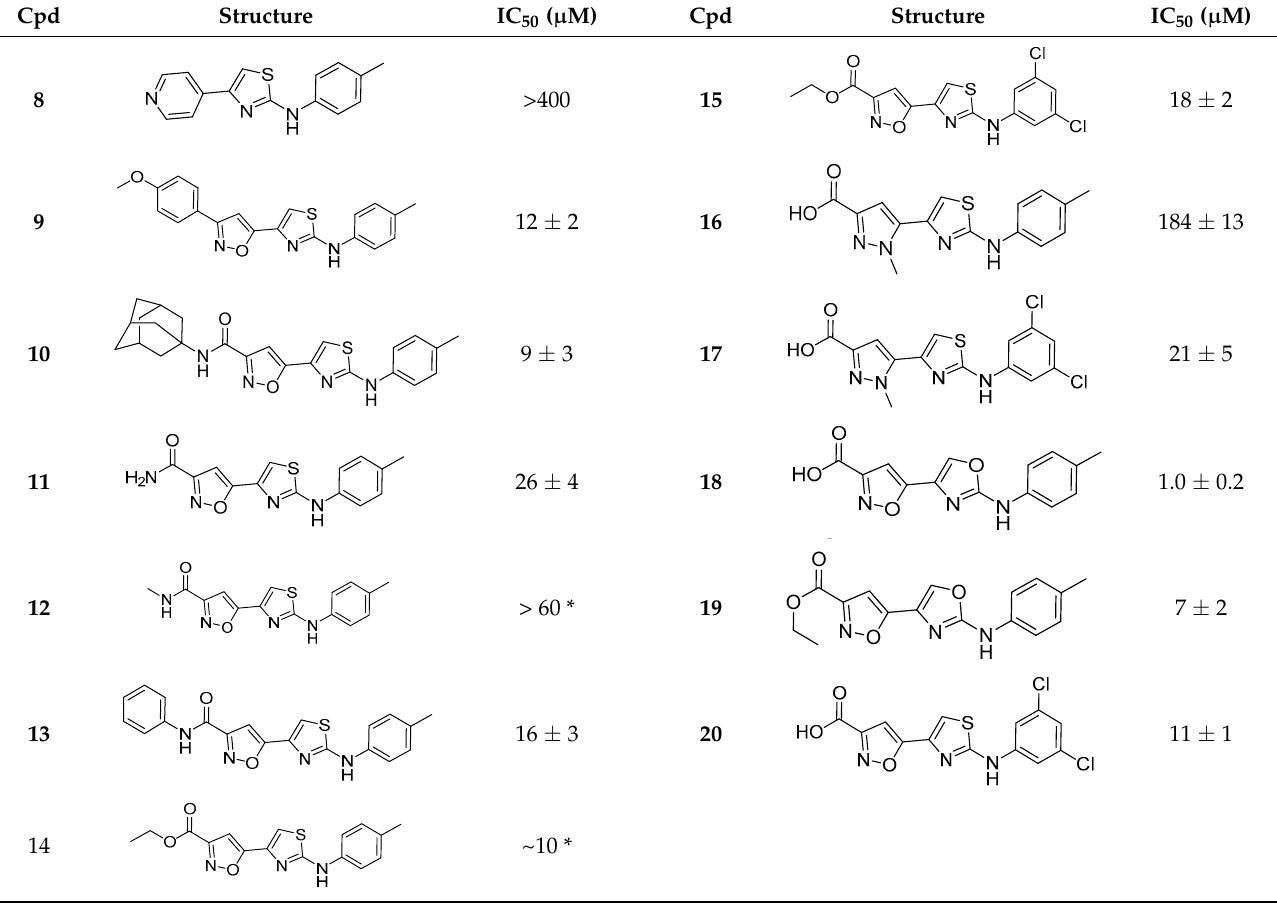
Table 2. St SAT Inhibitory activity of compound 5 analogues.